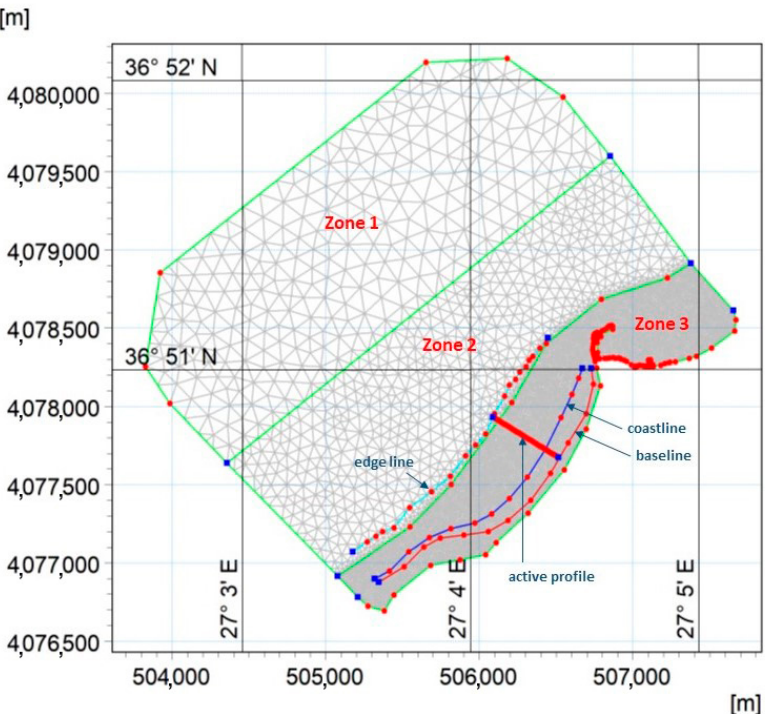
Figure 2. The three mesh density level zones in the computational domain, and the baseline, the coastline, the edge line, and the active profile elements used in the Shoreline Morphology module. Created in MIKE 21 mesh generator environment.